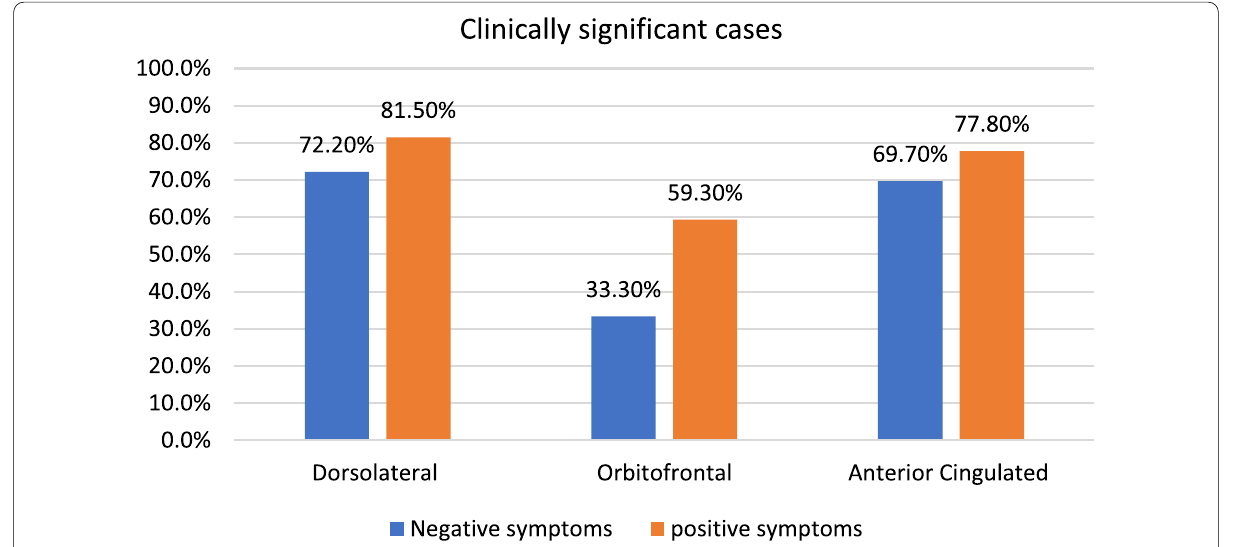
Fig. 4 Percentage of clinically significant cases in fronto‑subcortical syndromes in patients with positive and negative symptoms. The negative symptom scores have been adapted from the study of Ruiz‑Castañeda et al.